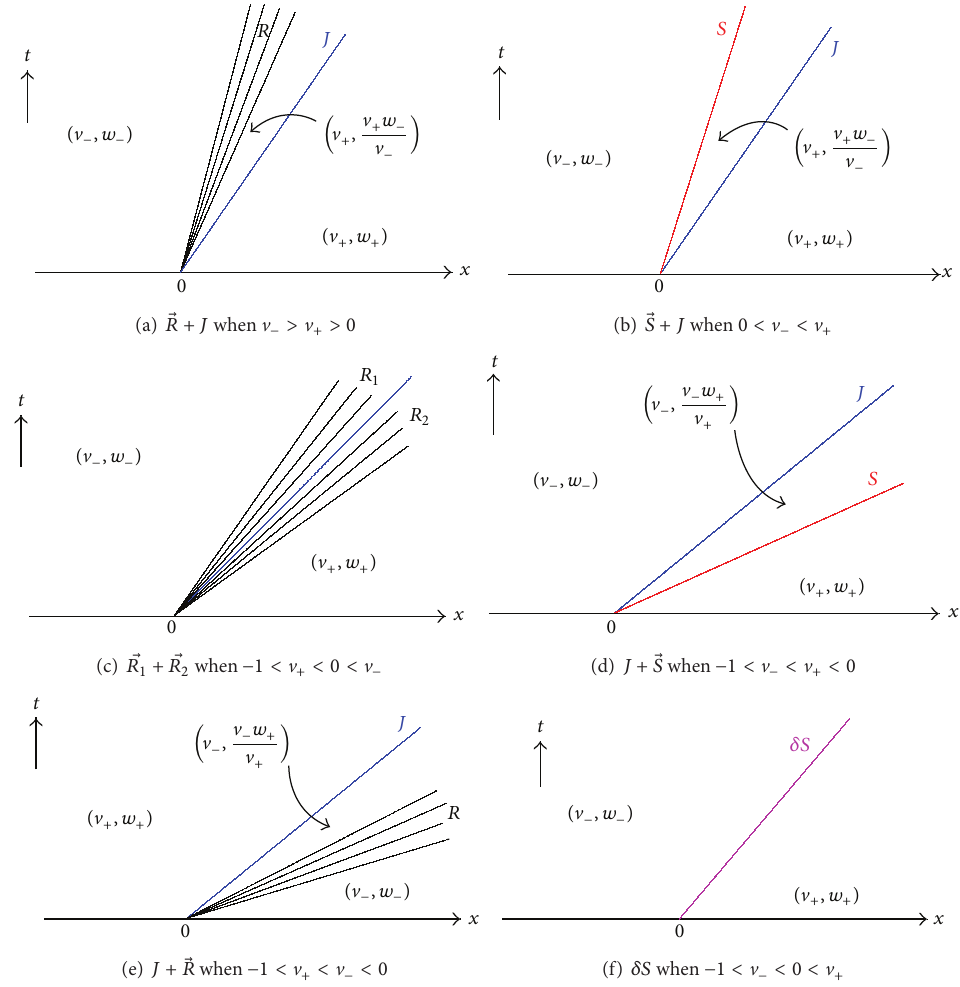
Figure 1: The Riemann solutions to (1) and (2) in all the